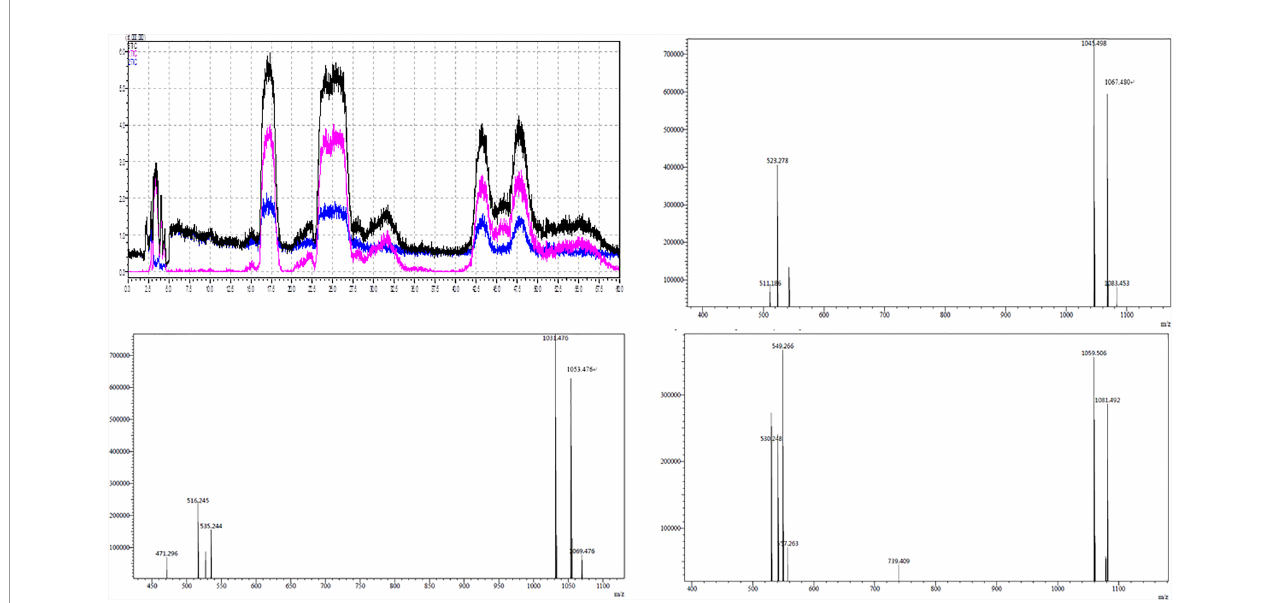
FIGURE 2 | LCMS-IT-TOF of secondary metabolite produced by B. amyloliquefaciens